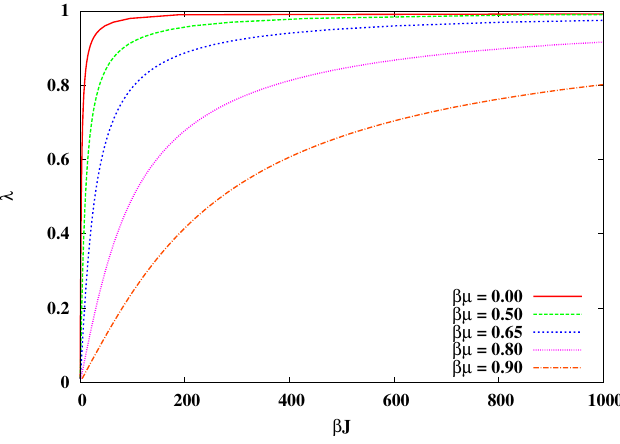
Figure 3 . The Lyapunov exponent (cid:21) is normalised and takes values between 0 and 1. This (cid:12)gure shows dependence of (cid:21) on (cid:12)J for di(cid:11)erent values of (cid:12)(cid:22) .